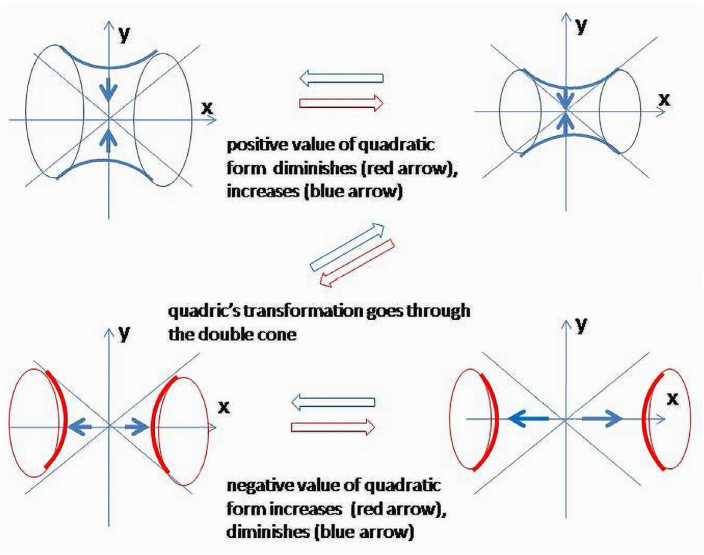
Figure 14. Transformation of hyperboloid of one sheet to hyperboloid of two sheets and vice